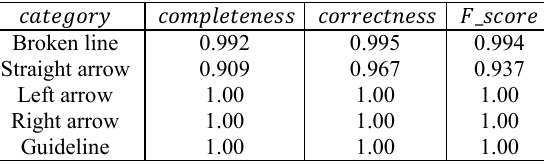
Table 2. Evaluation of marking